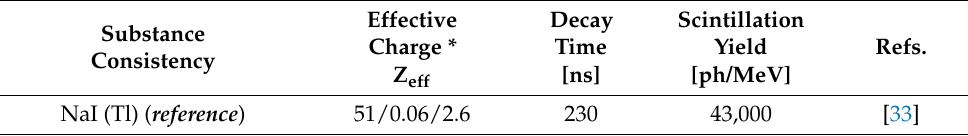
Table 2. Selected scintillation materials and their essential properties. Source: own study based on selected